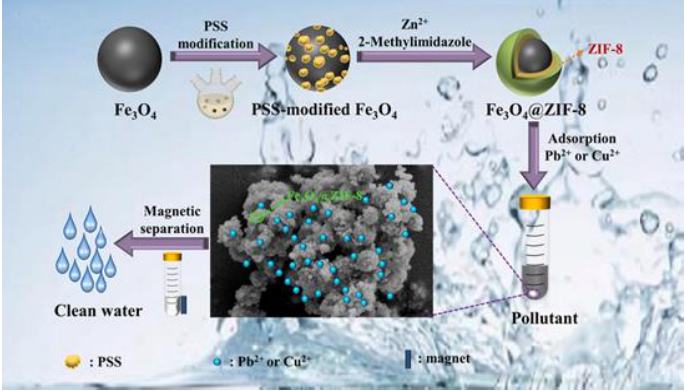
Figure 12. Preparation of Fe 3 O 4 @ZIF – 8 for removing metal ions. Reprinted with permission from Ref. [71]. Copyright 2021, Elsevier.